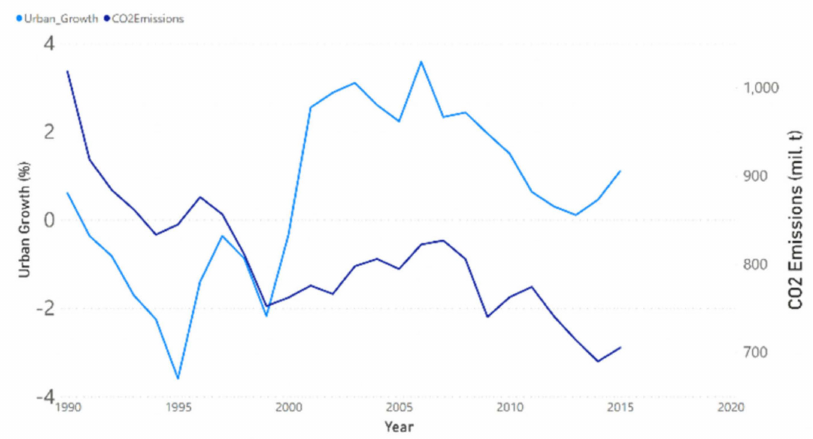
Figure 5. Urban population growth and CO 2 emissions.